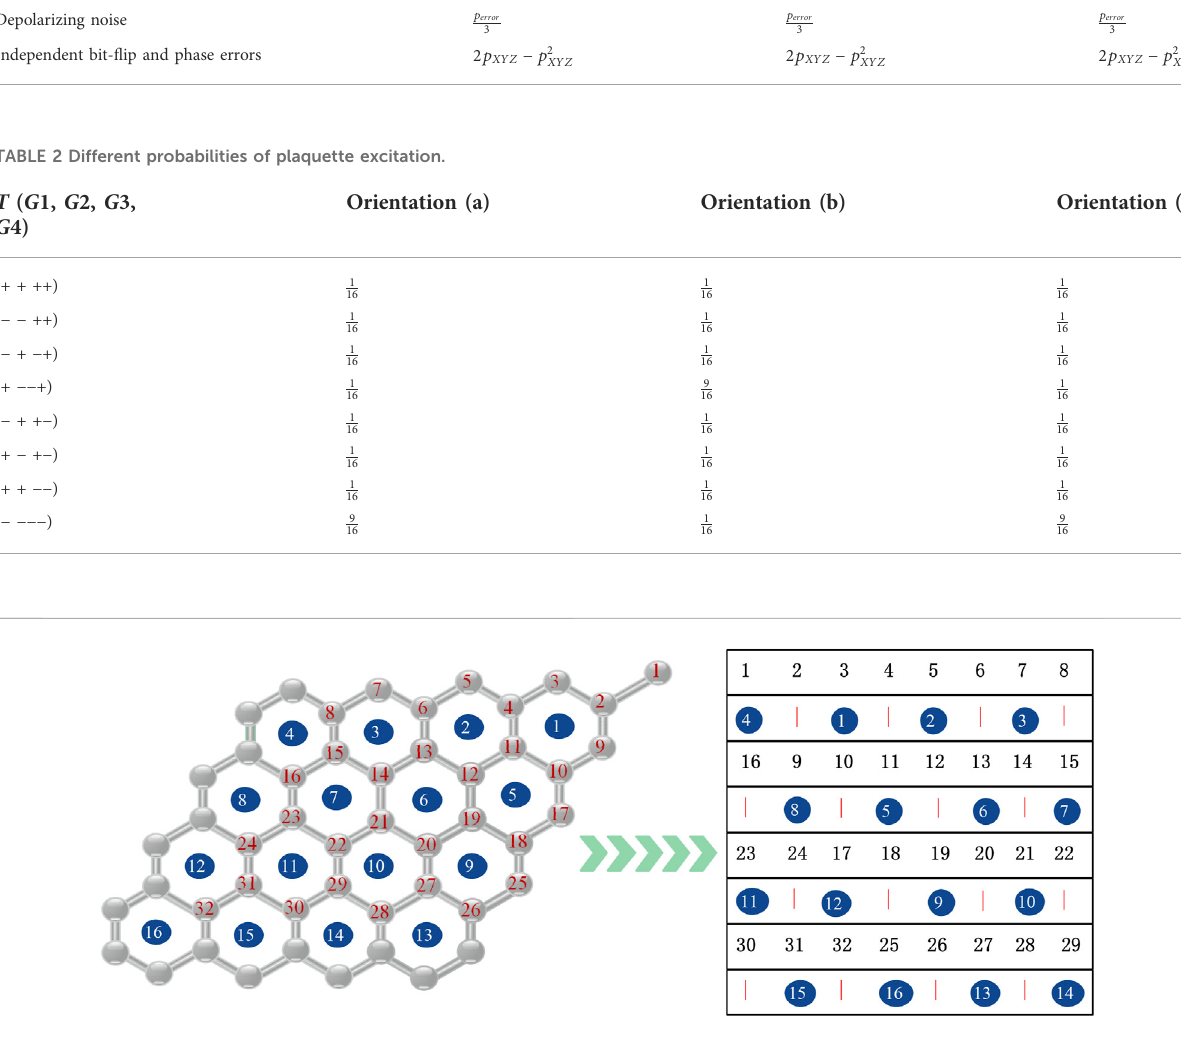
FIGURE 3 Lattice transformation square diagram. The left picture is a schematic diagram of a hexagonal lattice. The numbers with blue circles represent half calculations. There are 16 symbols in total, the red numbers are vertex operators, and there are 32 in total. The fi gure on the right is a converted square lattice. The numbers with blue circles represent plaquette operators, and red “ | ” represents the spatial structure. Extra values do not have any meaning, other numbers are vertices. In the previous fi gure, letters were used to represent vertices and plaquette operators. Due to the large number here, we use numbers to